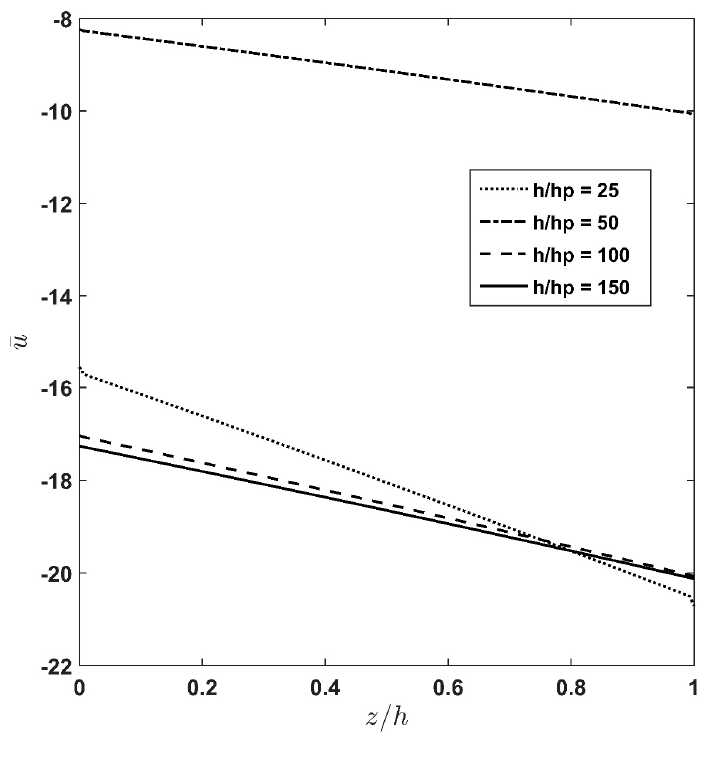
Figure 5. Effect of piezoelectric thickness variation on through-thickness distribution of dimensionless transverse normal stress, in-plane shear stress, and longitudinal displacement.